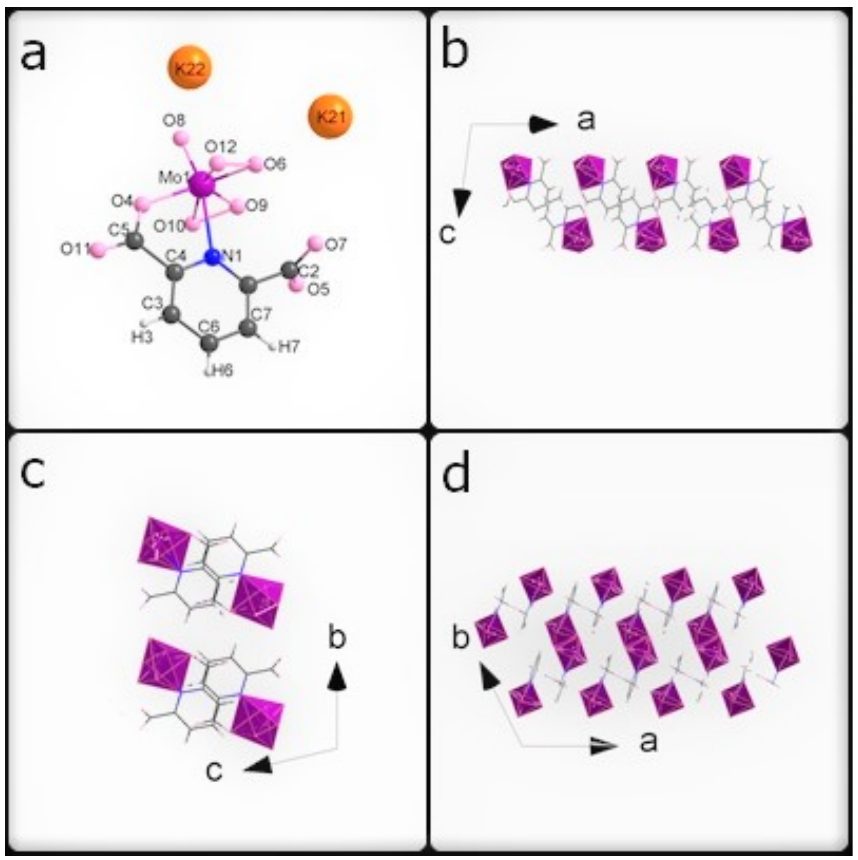
Figure 1. ( a ) The asymmetric unit of K26dcpa ; packing diagram of K26dcpa along ( b ) a axis, ( c ) b axis, and ( d ) c axis.